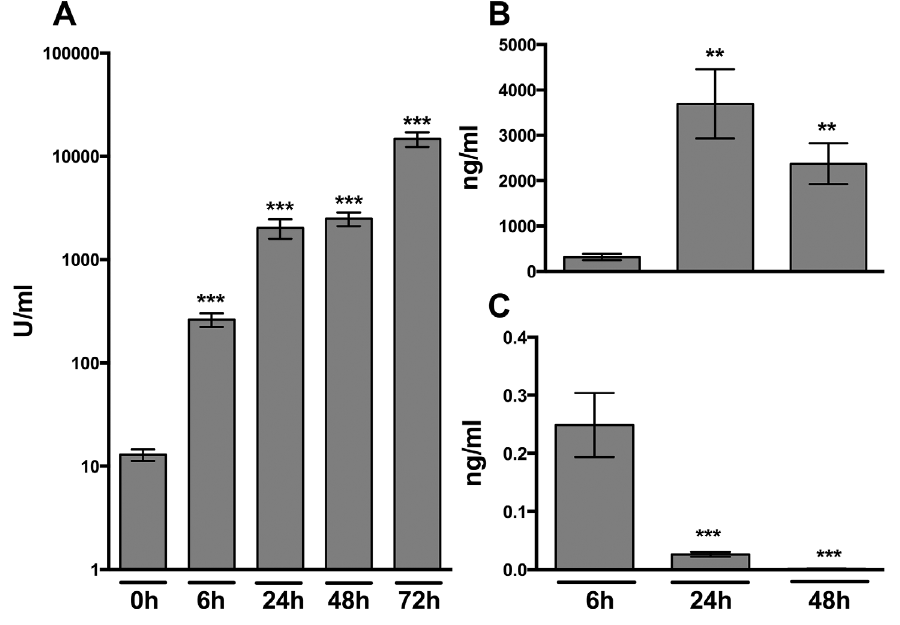
Figure 1. Nucleosome concentrations in mouse BALF during S . aureus pneumonia. Wt mice were intranasally infected with 1 × 10 7 CFU S . aureus and euthanized at the indicated time points. (A) Nucleosome concentrations in BALF quantified by ELISA and expressed as arbi- trary units. (B) Host cell-free DNA (mouse SOCS-3 ) in BALF quantified by PCR. (C) S . aureus DNA in cell-free BALF quantified by PCR. Data represent the means ± standard error of the mean ( n = 6–8 mice per time point). * p < 0.05, ** p < 0.01 and *** p < 0.001 versus naïve mice (0 and p < 0.001, respectively) and BALF (Figure 2B, p < 0.01 for both time points). Liver bacterial loads were similar in tlr9 –/–